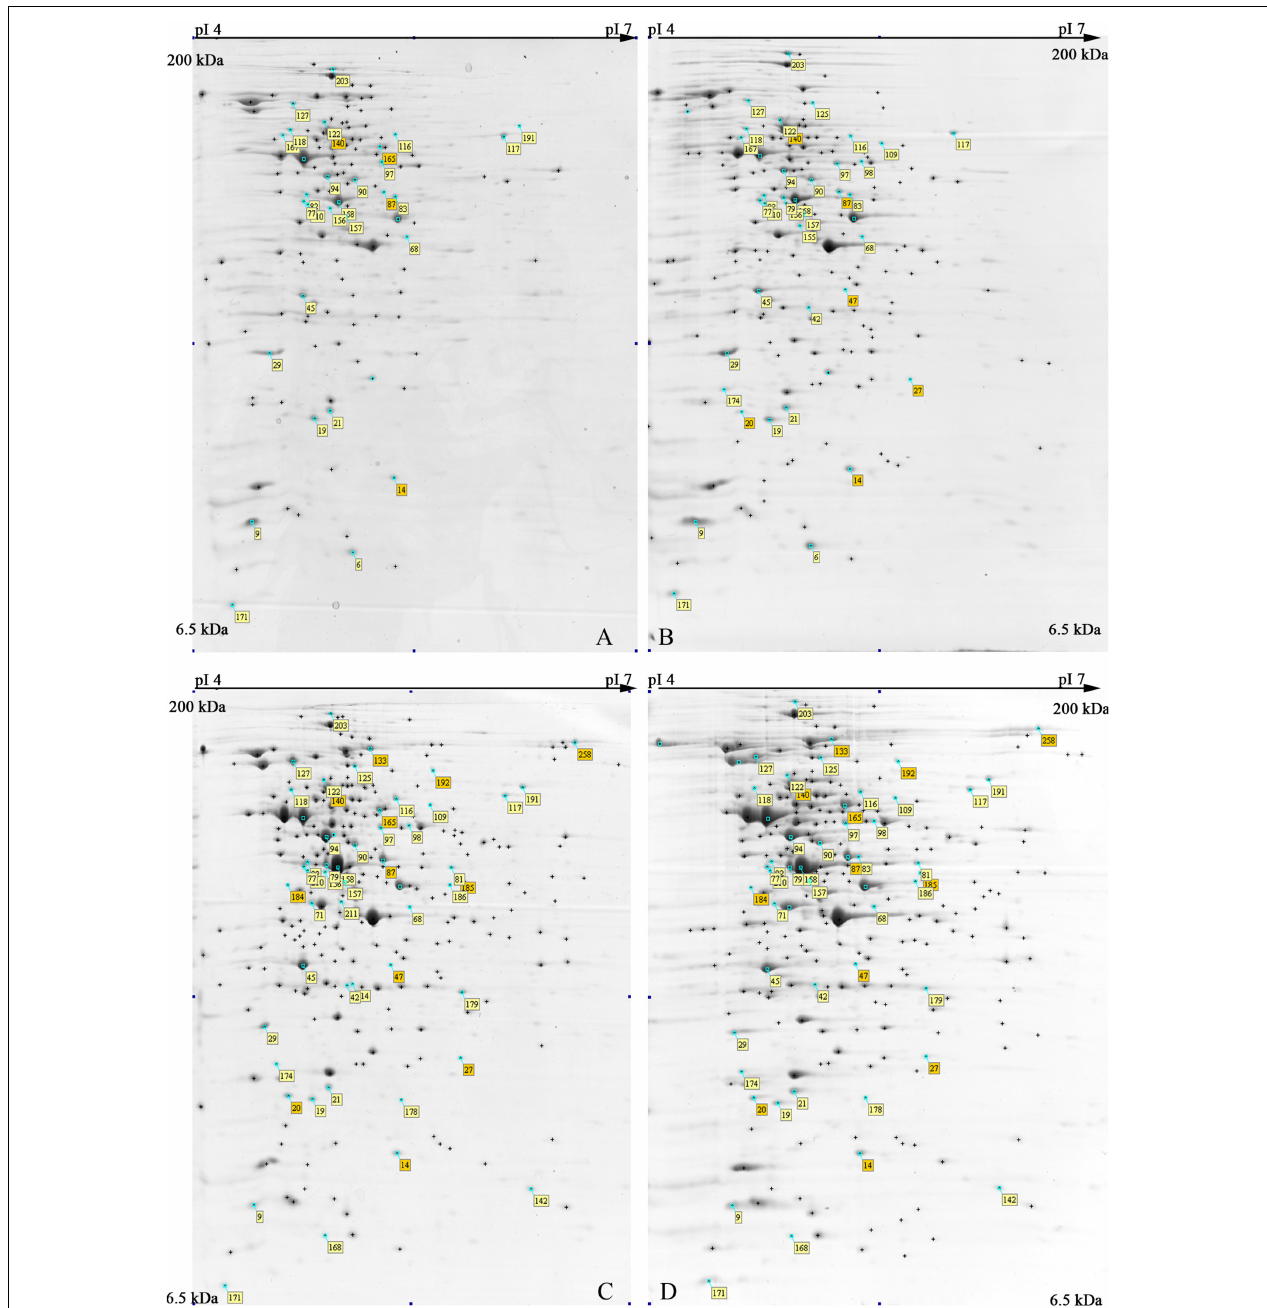
FIGURE 2 | Representative 2-DE maps of S. xylosus DSM 20266T grown in different conditions for 13 h: (A) synthetic medium in aerobiosis; (B) synthetic medium added with nitrite in aerobiosis; (C) synthetic medium in anaerobiosis; (D) synthetic medium added with nitrite in anaerobiosis. Protein spots showing significantly different intensities ( P < 0.05; ≥ of twofold; min Vol. 0.1%) are labeled by the corresponding match number in the square box, while yellow and orange marked identified and not identified proteins,